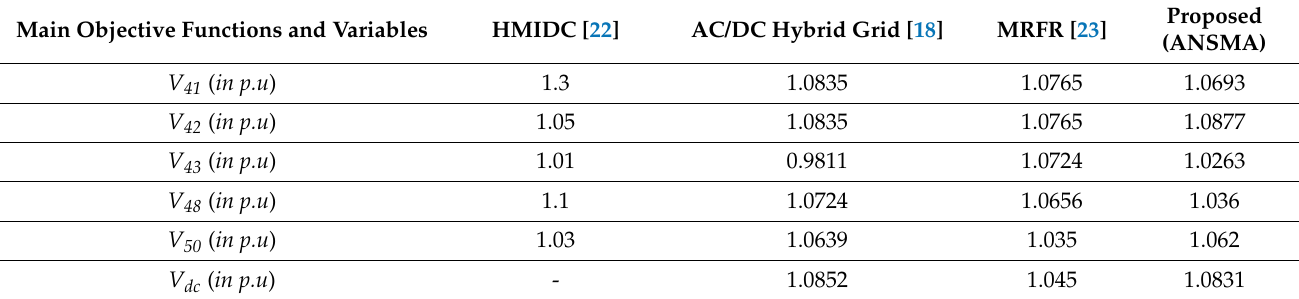
Table 2. Performance comparison of voltage deviation of the proposed ANSMA model with those of existing methods in IEEE 50-bus